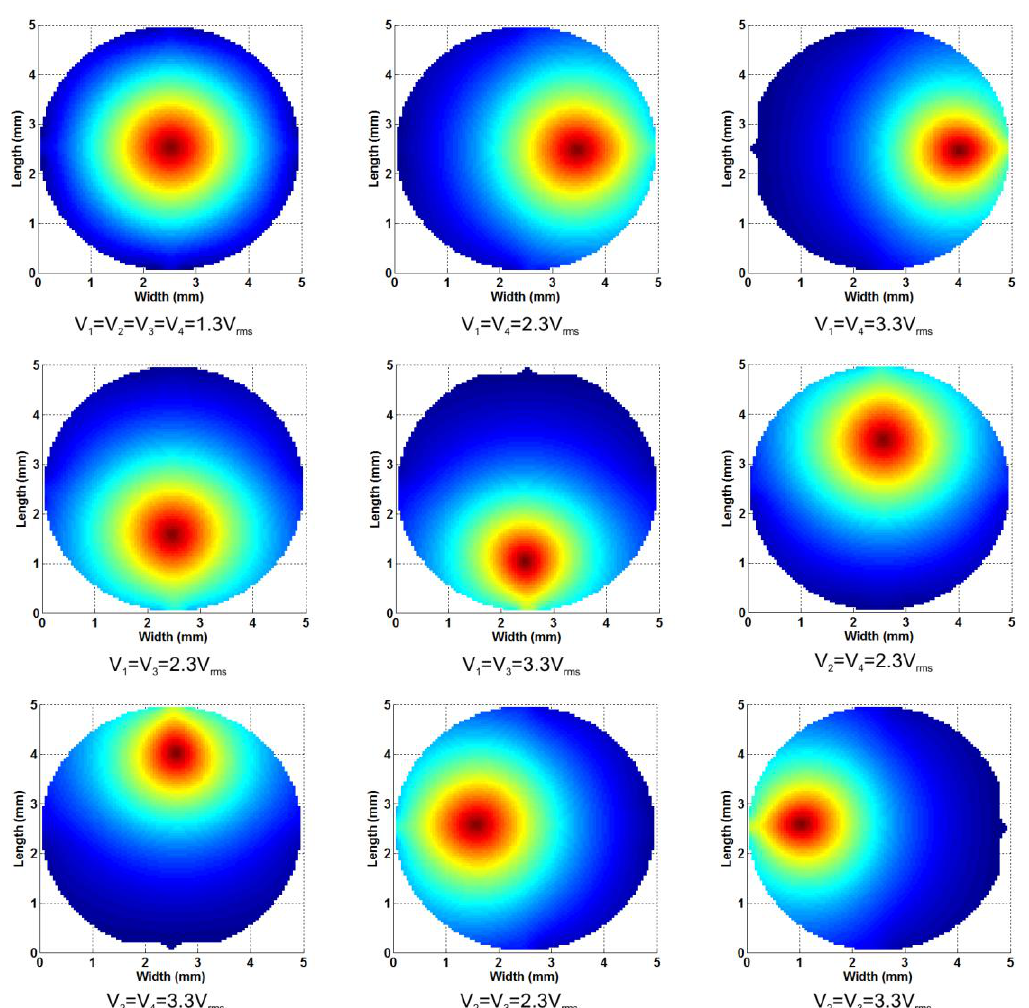
Figure 8. Optical phase shift in the XY plane several voltages applied to the